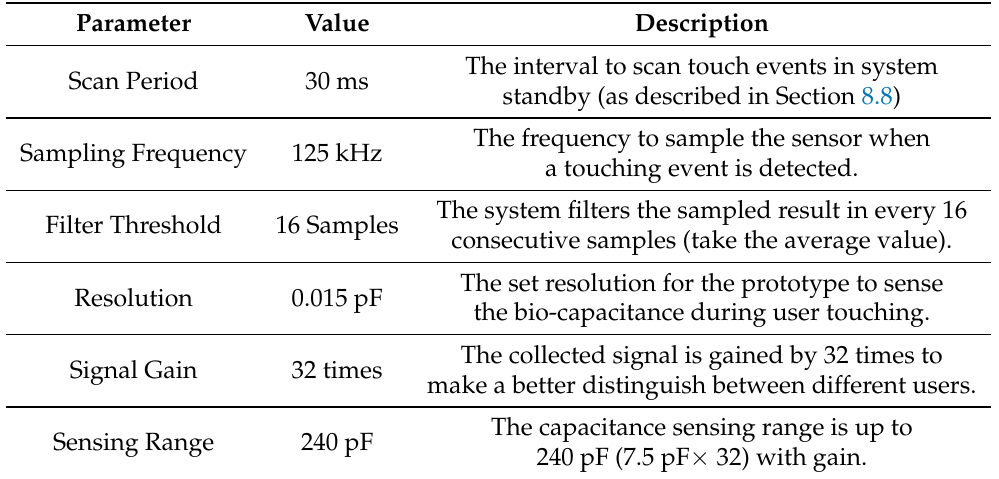
Table 2. The parameter configuration in the system